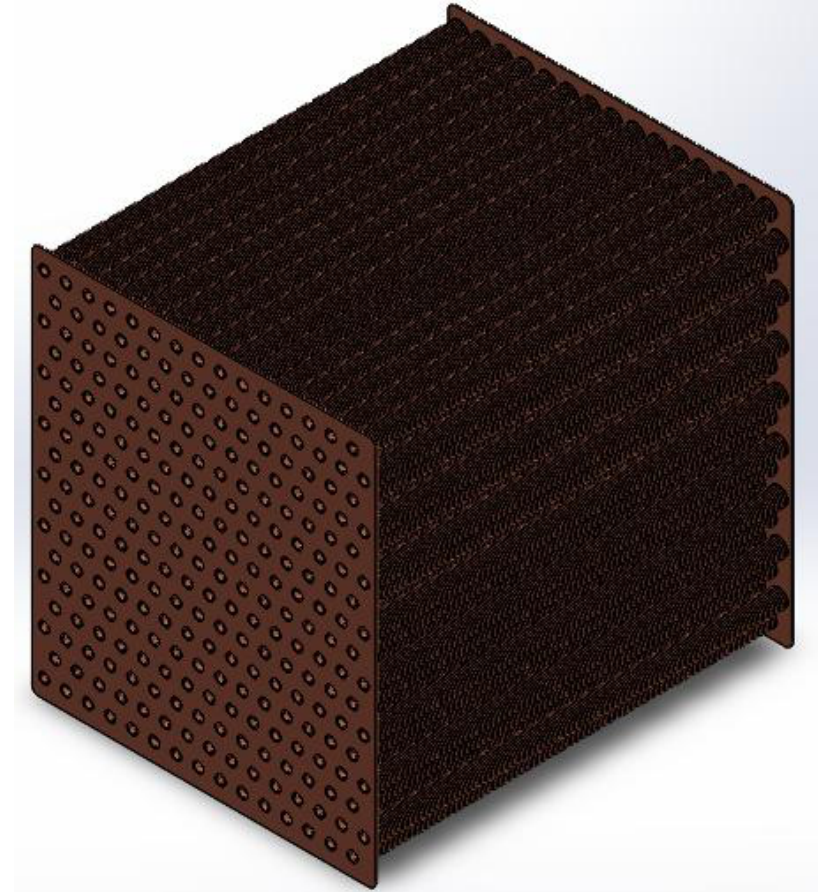
Figure 8. Assembly of the tube-fins parts with the plates, isometric